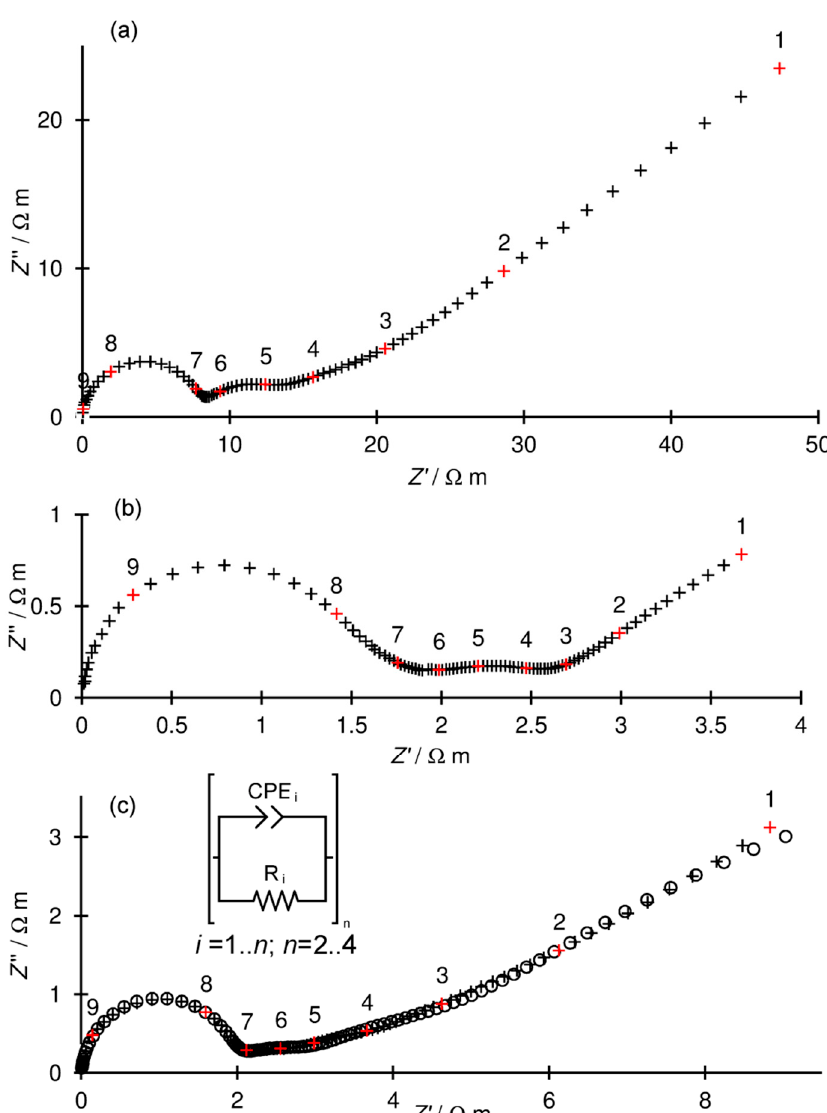
Figure 8. Complex impedance plane plots measured in air ( a ) at 287 °C for 2SBCY ceramics and ( b ) at 507 °C for 5SBCY ceramics; ( c ) an example of fit for 2SBCY ceramics measured at 407 °C; crosses indicate measured data, circles indicate the fitted model; numbers above red symbols denote logarithms of frequency.